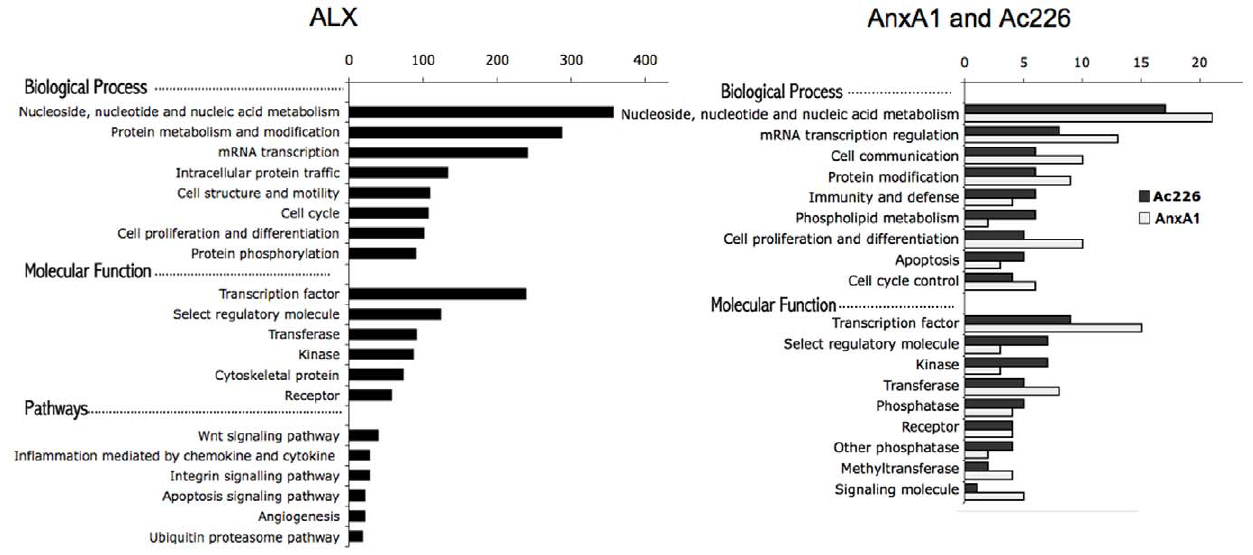
Figure 4. Functional analysis of differentially expressed genes. Representative categories of biological process, molecular functions and pathways are shown. Functional analysis of the 3120 differentially expressed probes in ALX group ( left ) and analysis of the 103 and 118 altered probes in Ac226 and AnxA1 groups, respectively ( right ). Panther Classification System was used for this analysis.